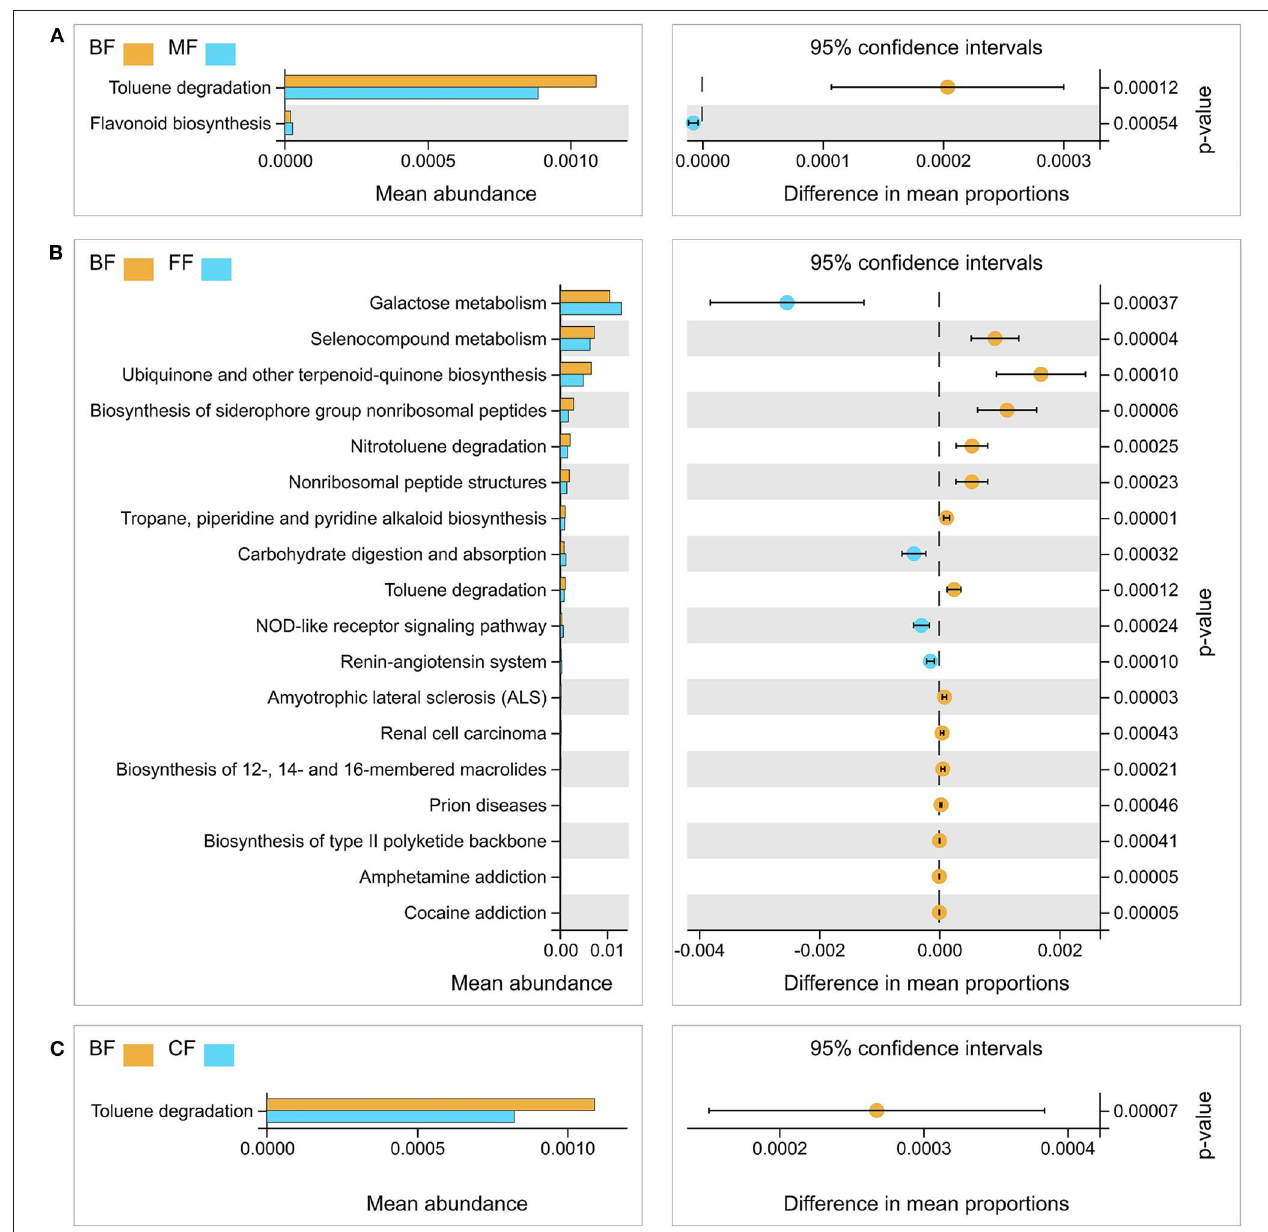
FIGURE 3 | Functional differences analysis between the breastfed (BF) group and the other three groups, respectively. (A) The BF group vs. the mixed-fed (MF) group. (B) The BF group vs. the formula-fed (FF) group. (C) The BF group vs. the CF group.